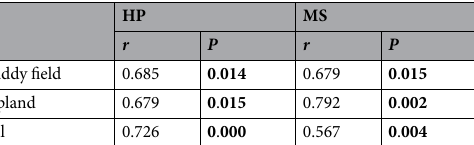
Table 2. Pearson correlation coefficients ( r ) between R 20 values and POXC. HP and MS represent Huaping and Meishan, respectively (n = 12).